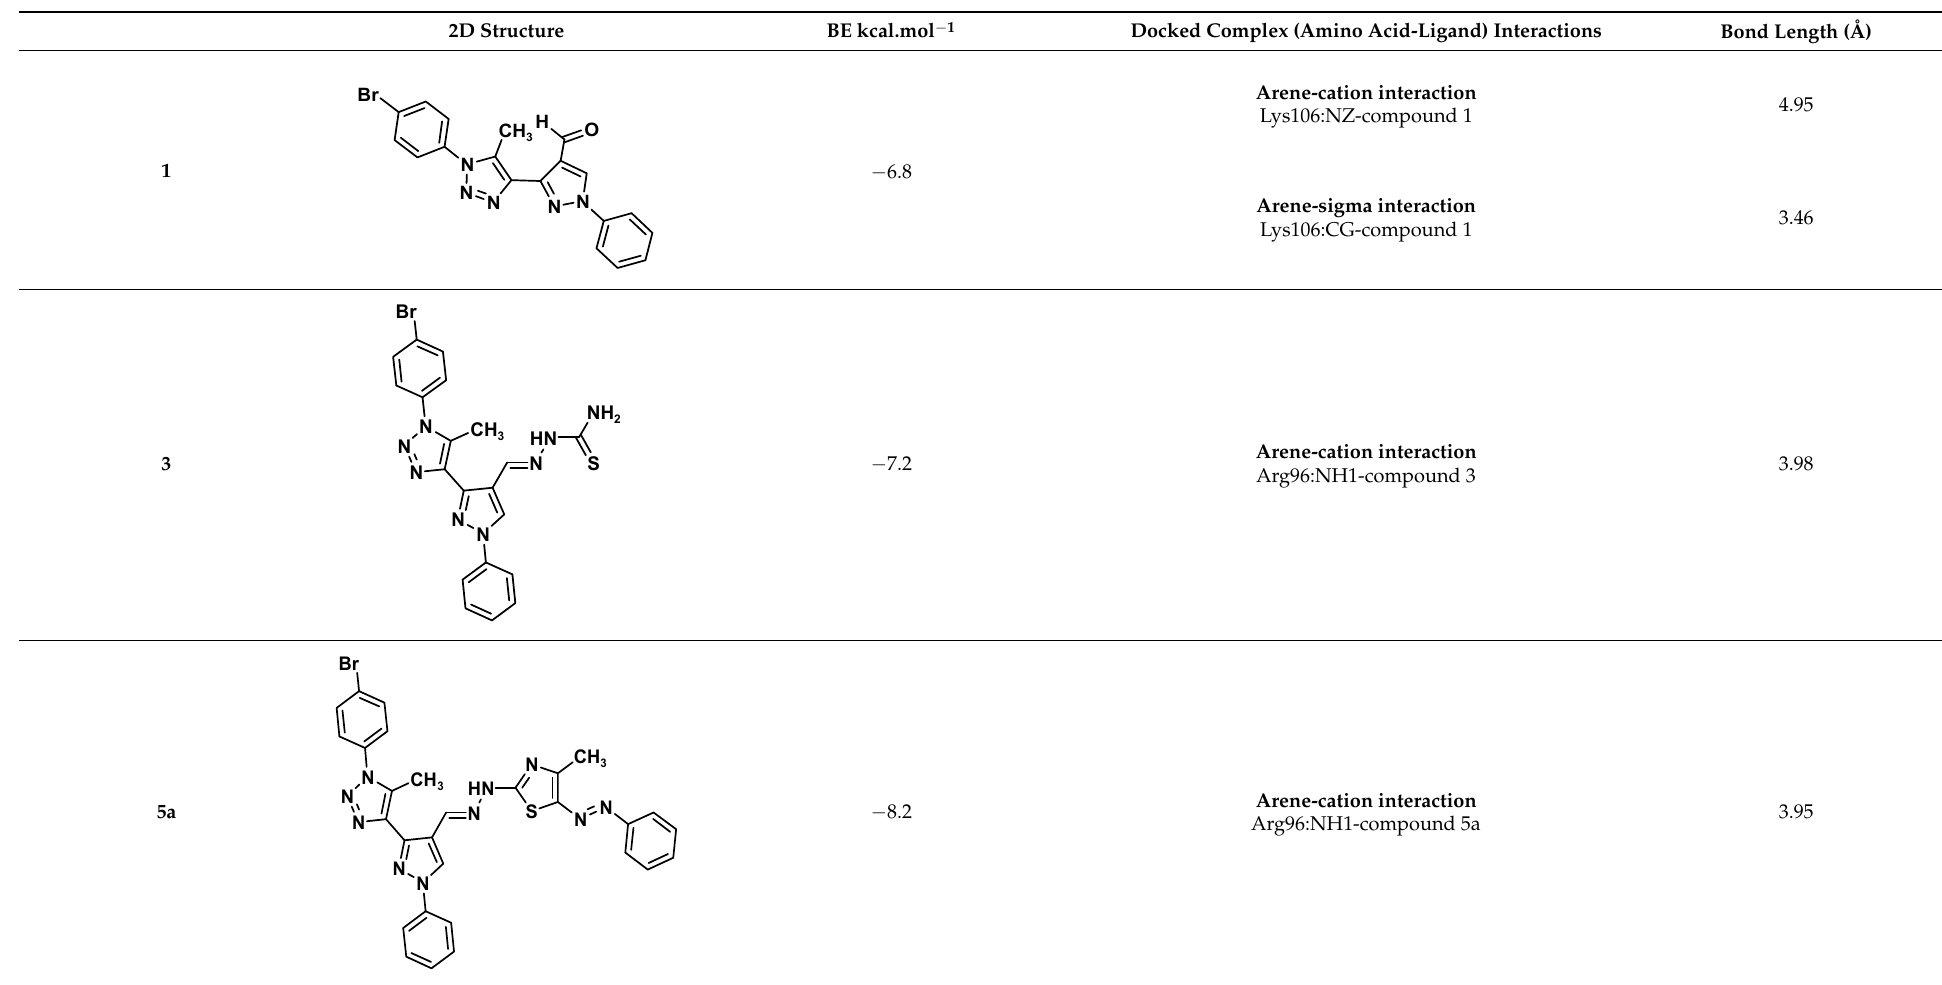
Table 1. Molecular docking results for the screened compounds and Rho6 protein.